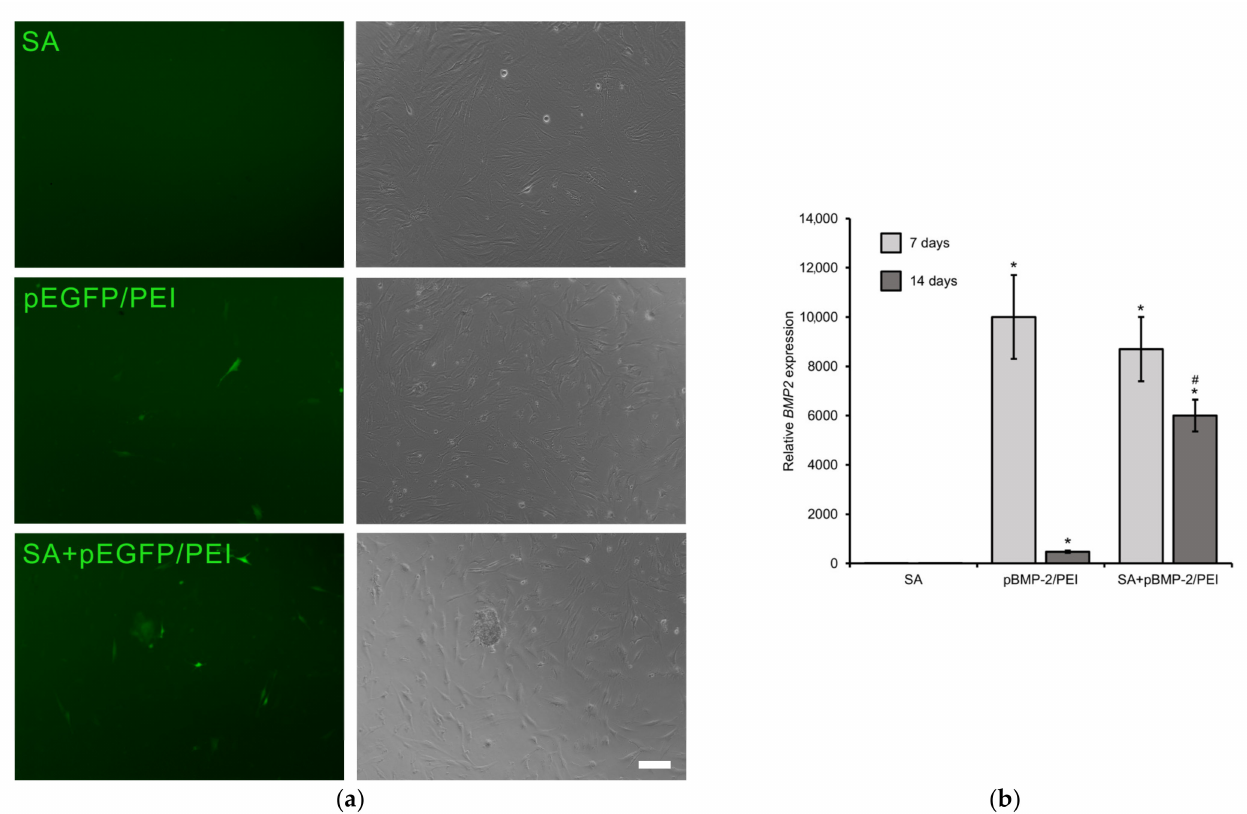
Figure 3. Transfection in vitro. ( a ) Transfected MSCs after 3 days of incubation with pEGFP/PEI and after 7 days of incubation with gene-activated scaffolds impregnated with pEGFP/PEI. Fluorescent (left) and light (right) microscopy. Scale bar 100 µ m; ( b ) Relative BMP2 expression level after 1 and 2 weeks incubation of MSCs with gene-activated scaffolds impregnated with pBMP-2/PEI. Real-time PCR. *— p < 0.05 (vs. SA) and #— p < 0.05 (vs.